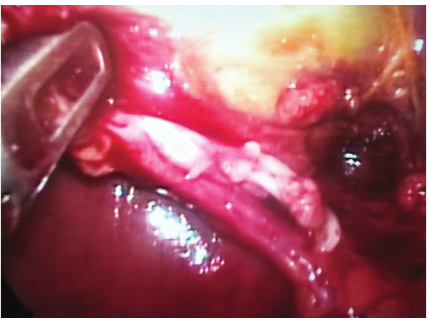
Figure 5: Clipped cystic